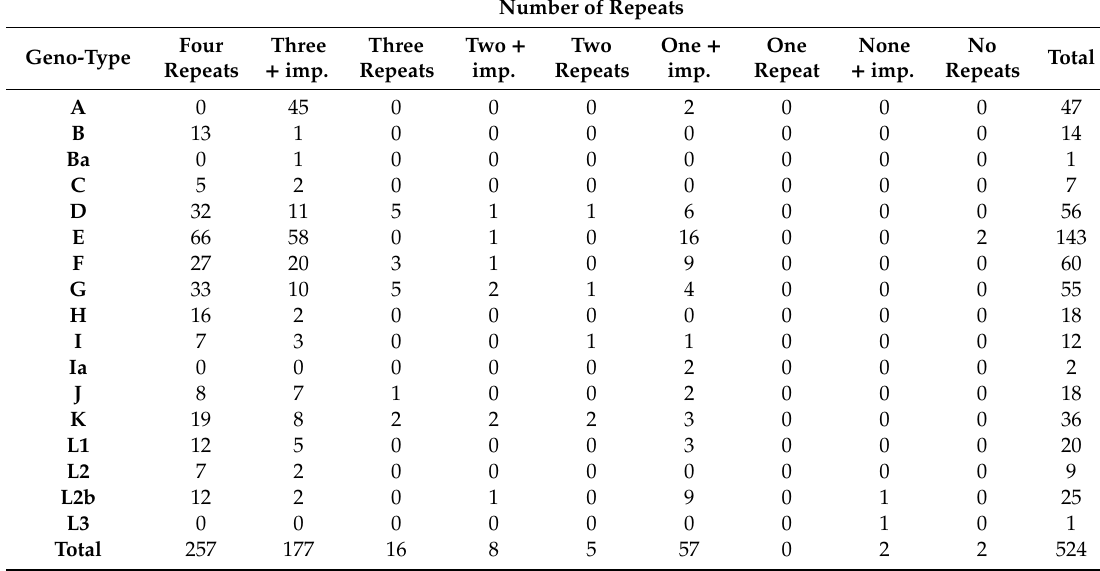
Table 6. Number of repeats in the 22 bp repeat region per genotype according to the automated alignment process. Imperfect repeats (any variation of a perfect repeat) are abbreviated to “imp.” in the